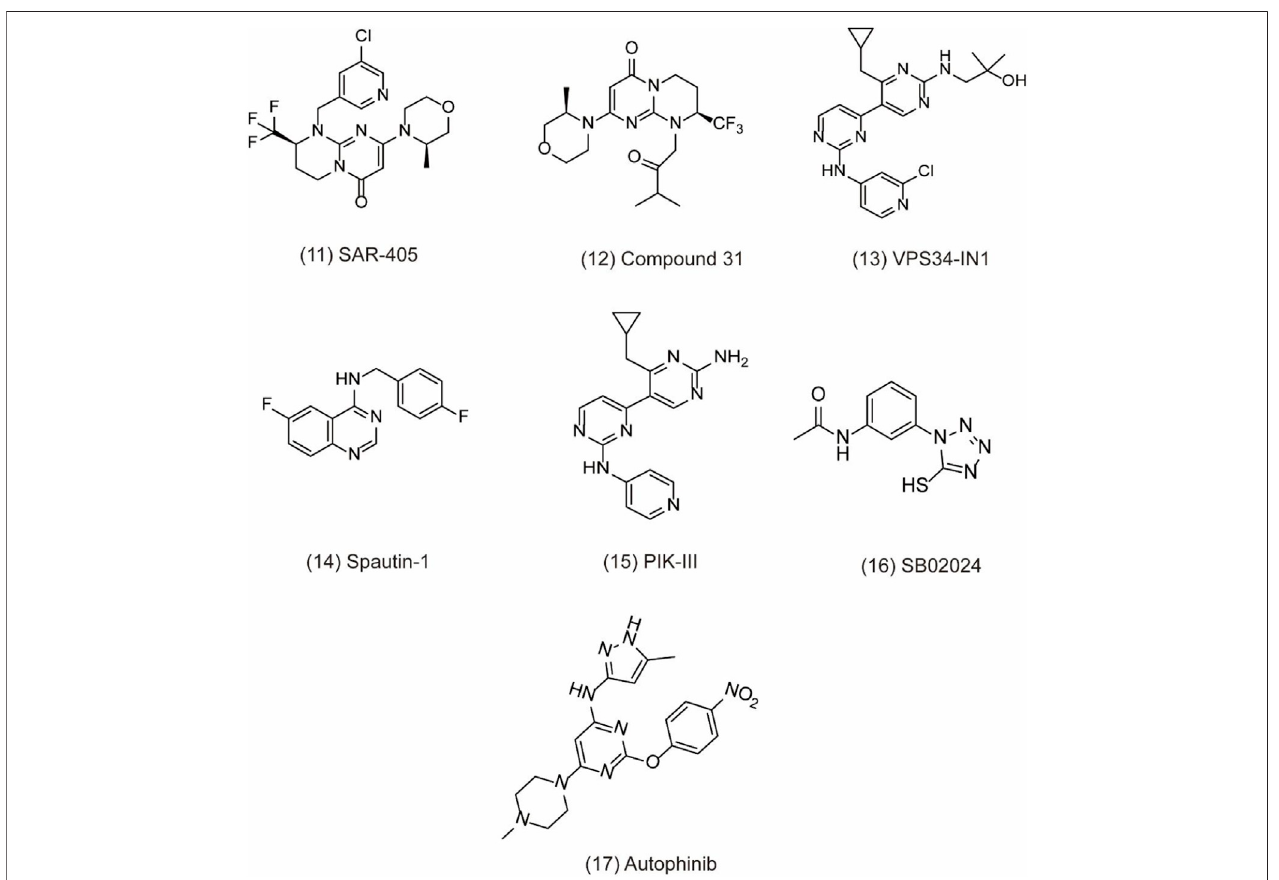
FIGURE 4 | Chemical structures of 11 – 17 as inhibitors of autophagy by targeting